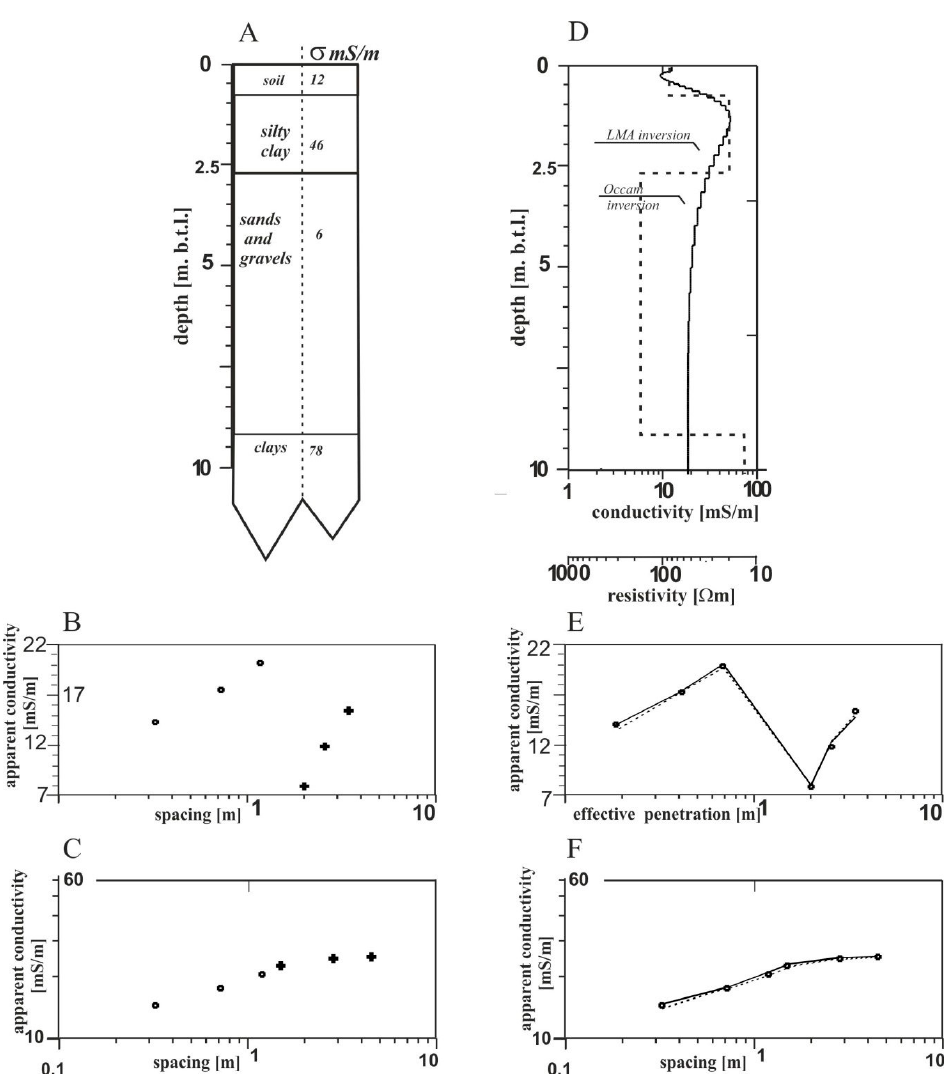
Figure 2. Plots of the forward modeling data and their interpretation of the results using